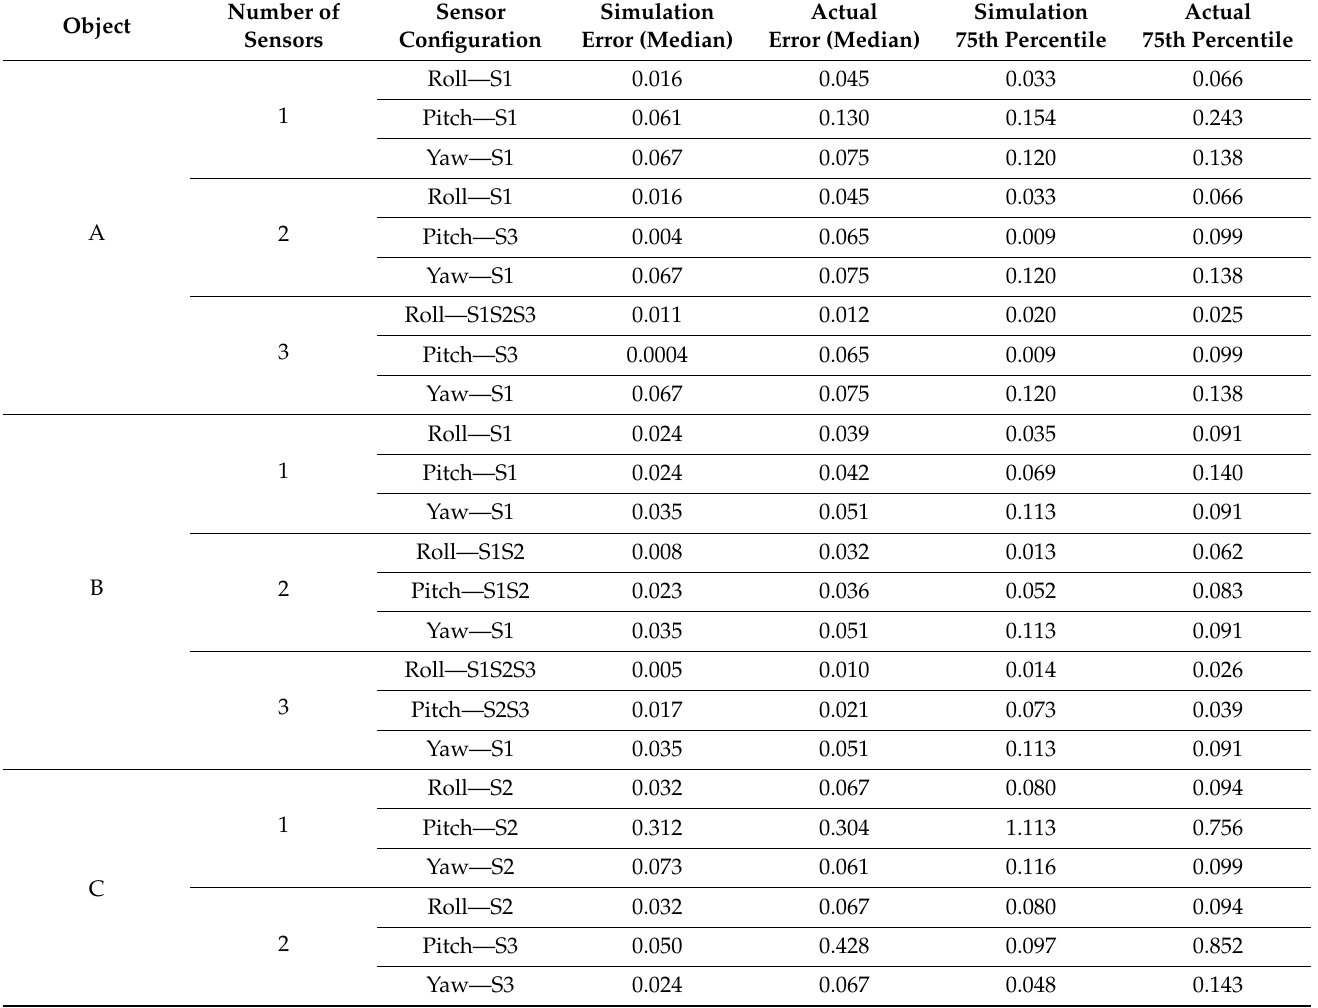
Table 1. Detection error (median and 75th percentile) of selected configurations based on simulation and comparison of measurement results on the real system for all objects. All values are in